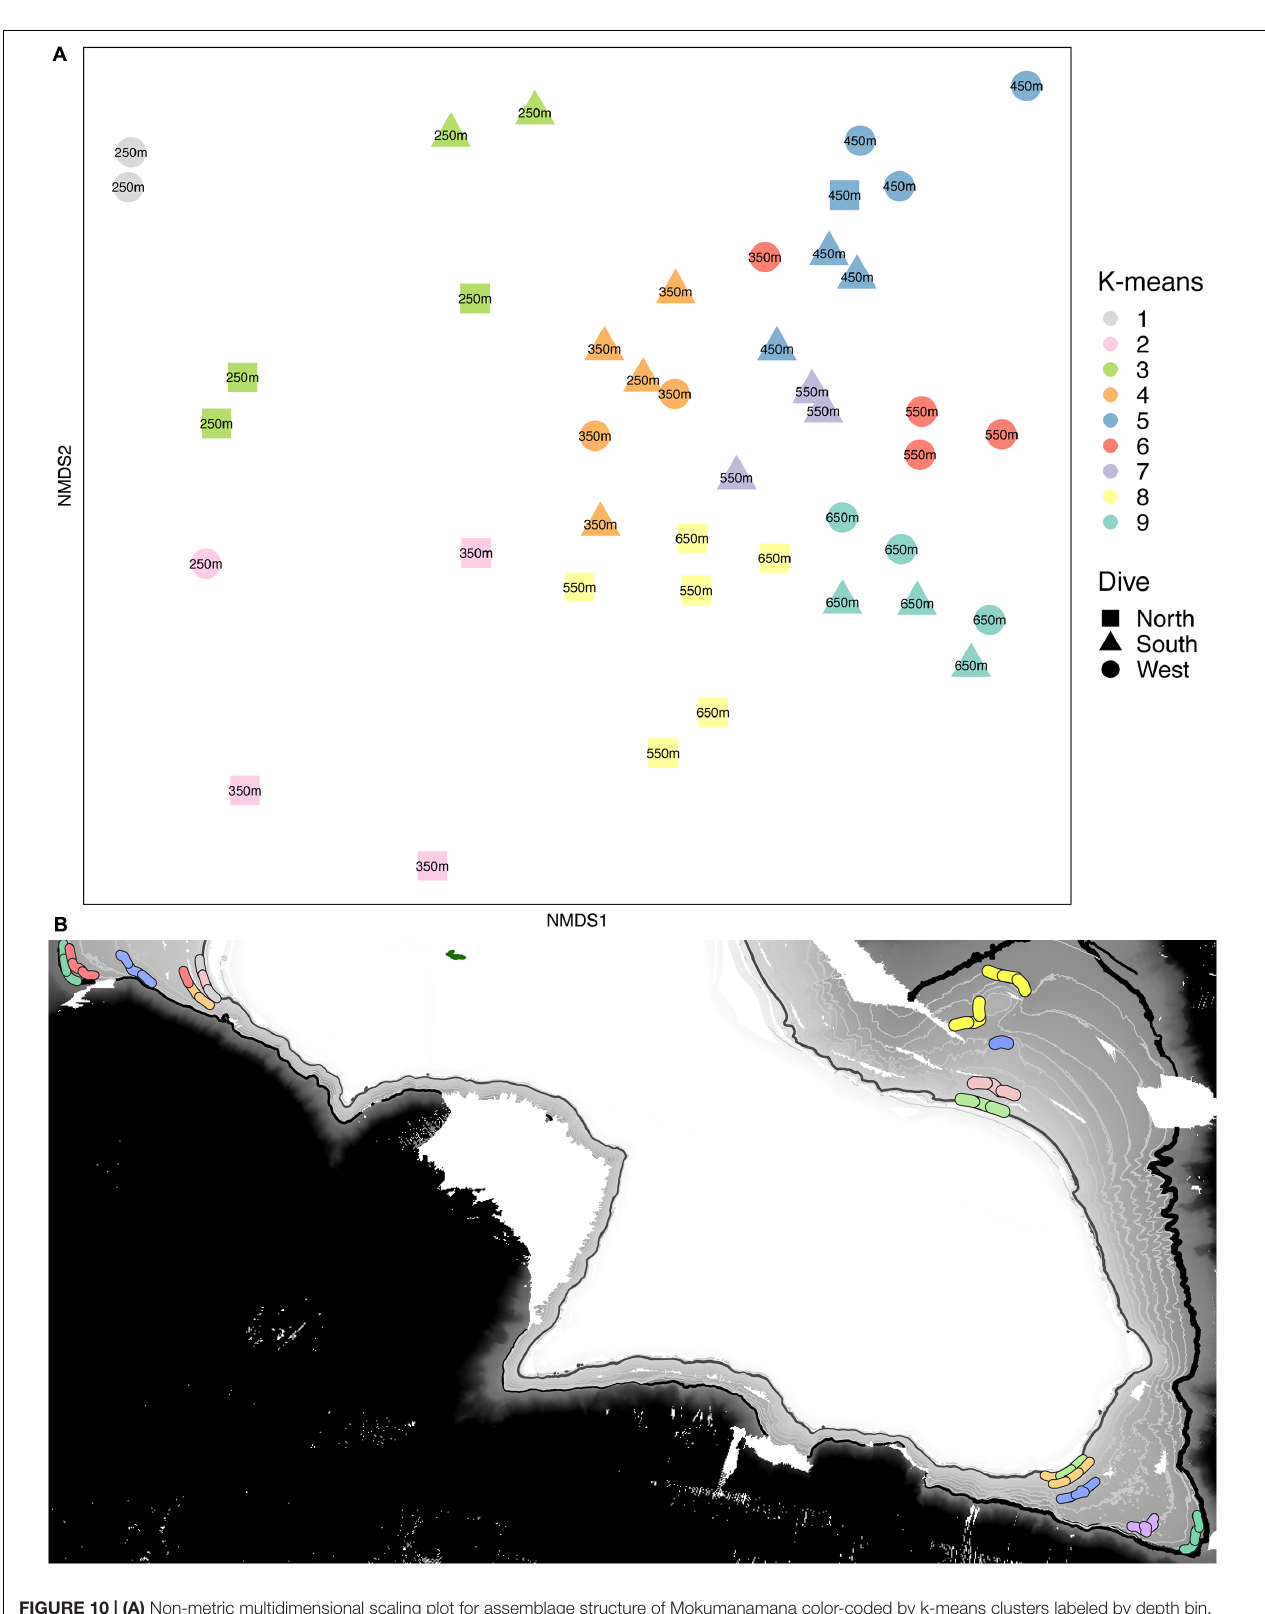
Frontiers in Marine Science |